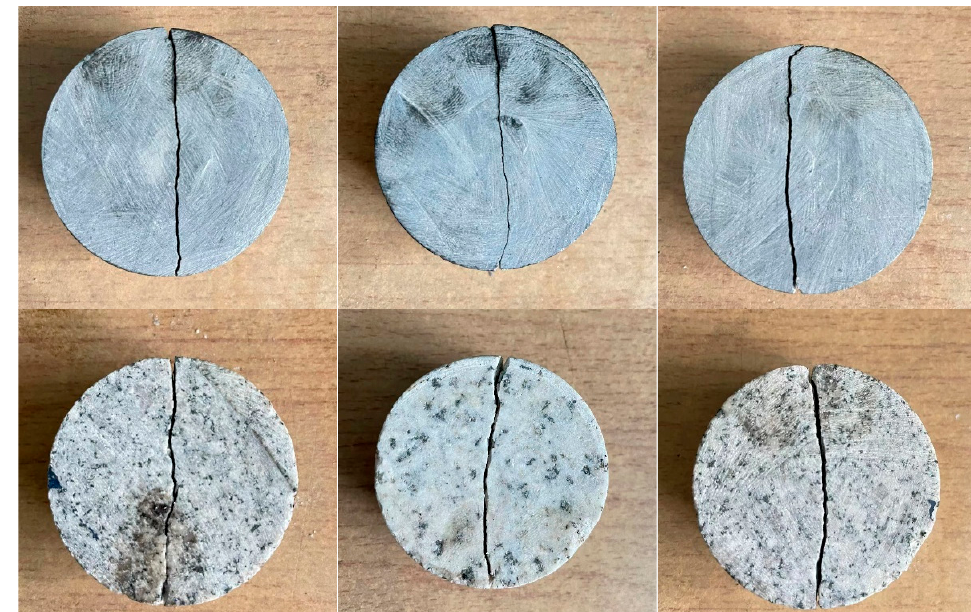
Figure 3. Failure patterns of some specimens under static load (slate and granite).